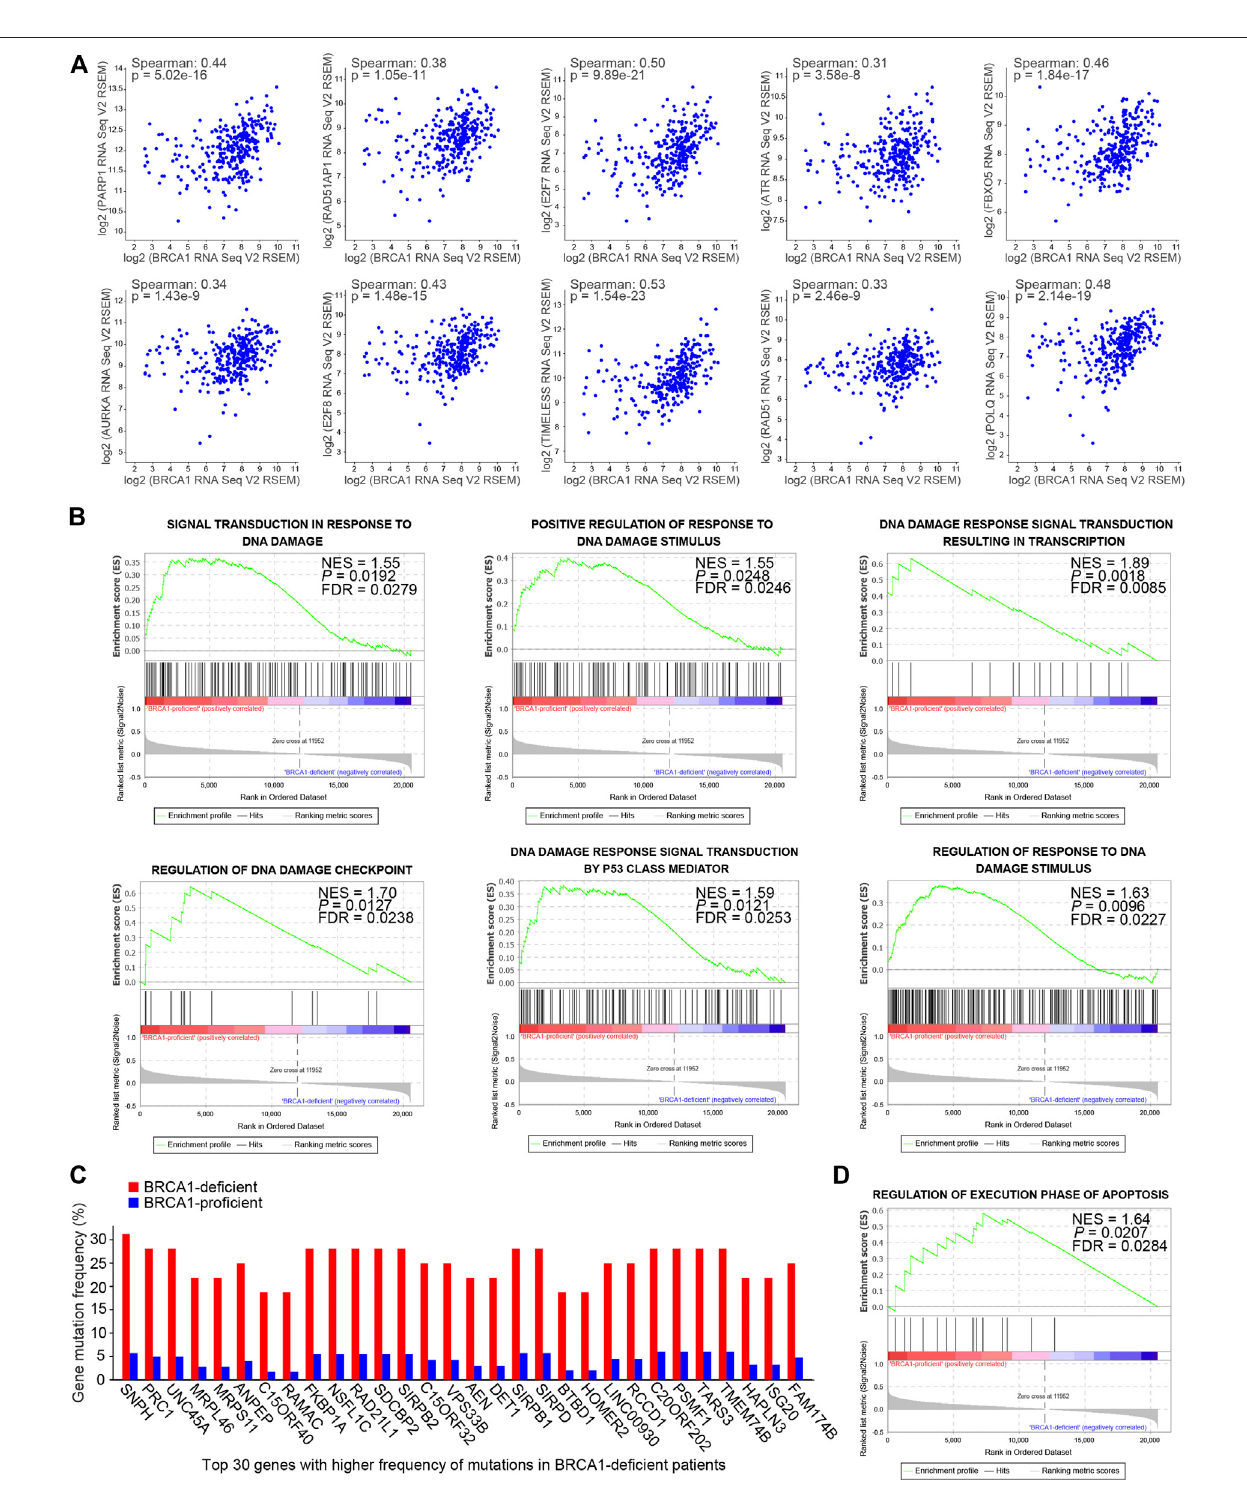
FIGURE 2 | DNA damage responses were compromised in BRCA1-de fi cient ovarian cancer patients. (A) mRNA expression correlation analysis of the BRCA1 gene and genes related to DNA damage response among the ovarian cancer patients. BRCA1 gene expression was positively correlated with these genes. Spearman: spearman correlation coef fi cient. (B) GSEA analysis of gene sets related to DNA damage responses based on the normalized mRNA expression data (RNA Seq V2 RSEM) between BRCA1-pro fi cient ( n = 275) and -de fi cient ( n = 29) patients. NES, normalized enrichment score. FDR, false discovery rate. Positive NES indicates lower expression in BRCA1-de fi cient patients. (C) Gene mutation frequency analysis between BRCA1-de fi cient patients (red) and -pro fi cient patients (blue). Top 30 geneswithsigni fi cantlyhigher frequencyofmutations inBRCA1-de fi cient patients compared withBRCA1-pro fi cient patientsare shown. (D) GSEA analyses ofgeneset related to regulation of execution phase of apoptosis based on the normalized mRNA expression data (RNA Seq V2 RSEM) between BRCA1-pro fi cient ( n = 275) and -de fi cient ( n = 29) patients. NES, normalized enrichment score. FDR, false discovery rate. Positive NES indicates lower expression in BRCA1-de fi cient patients. Frontiers in Cell and Developmental Biology |